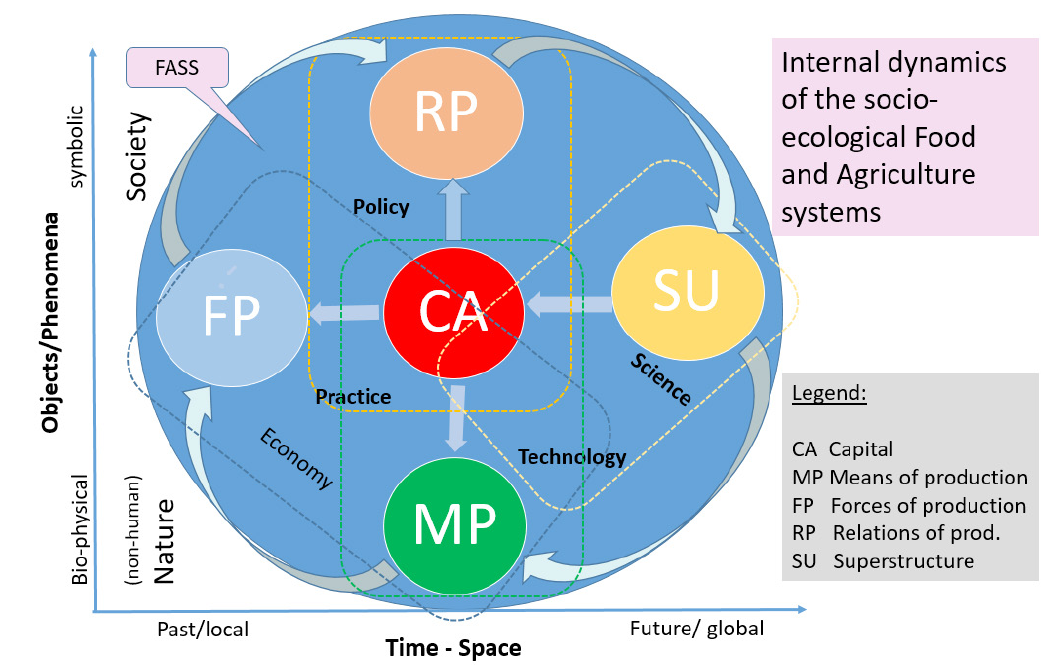
Figure 3: The dynamic relationship between the five mega-structures Capital (CA), Means of production (MP), Forces of production (FP), Relations of production (RP) and Superstructure (SU) within time-space and the gradients defined by material and symbolic matter. This framework 3 describes the dynamic cycle of the mega-structures within